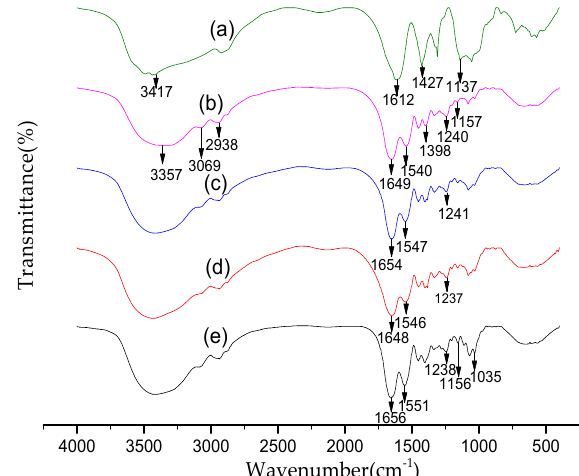
Figure 3. FTIR spectra of (a) carboxymethyl chitosan, (b) COP, (c) CMC – COP12, (d) CMC – COP26, and (e) CMC – COP58.